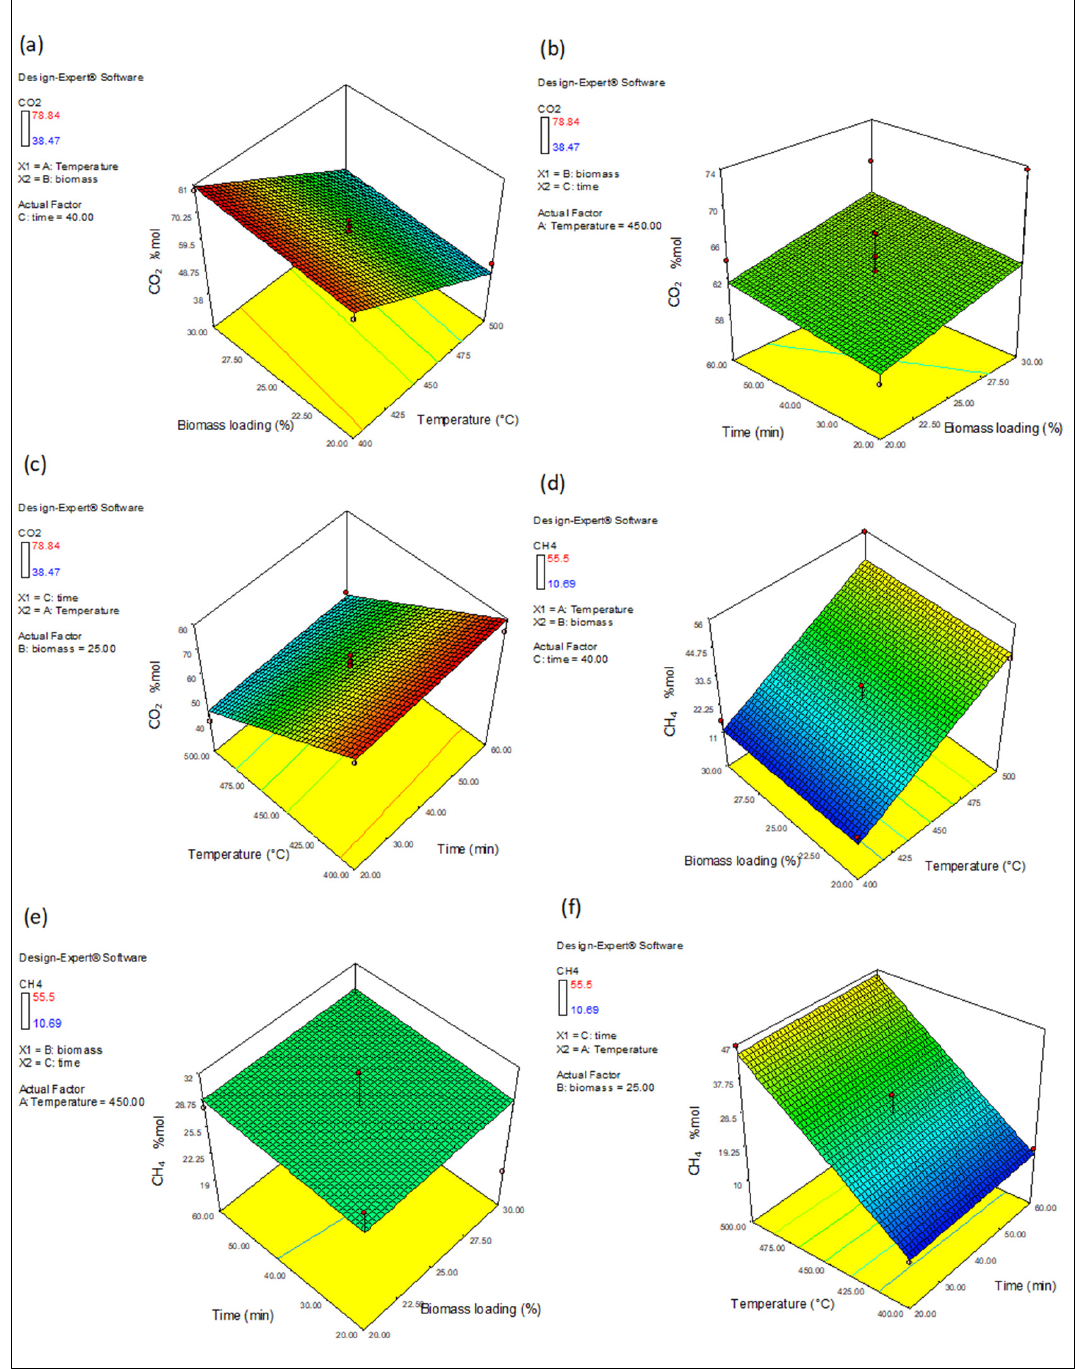
Figure 11. Three-dimensional response surface graphs of interaction e ff ects of variables on gas composition: CO 2 ( a – c ) and CH 4 ( d – f ) yields.